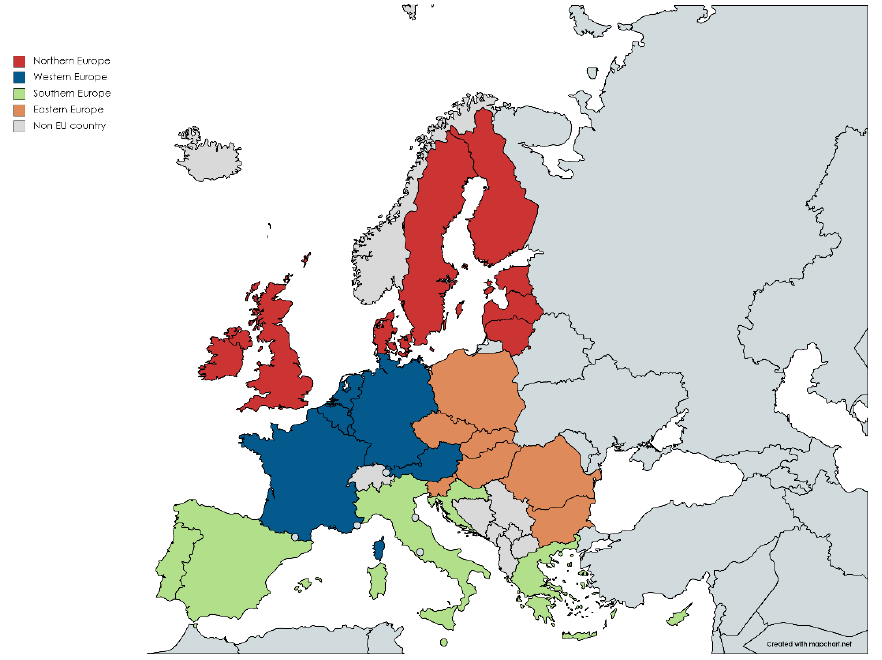
Figure 4. Map of EU DALYs 2019 according to United Nation Geoscheme classification. Source: MapChart.net [10,11].